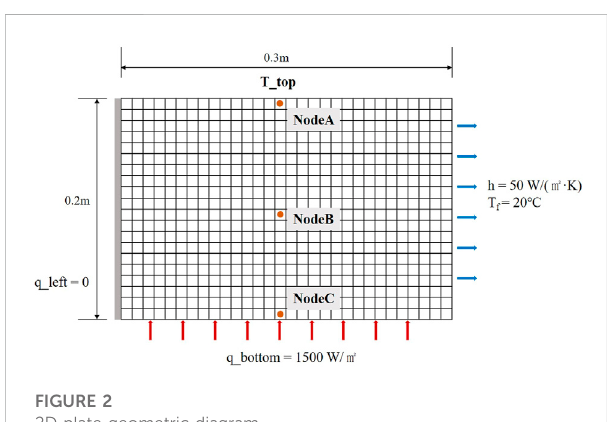
FIGURE 2 2D plate geometric